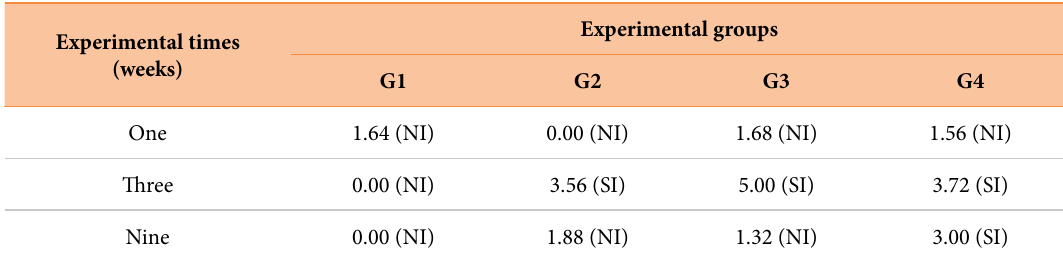
Table 1 - Irritation pattern of poultry collagen-based hydrogels in subcutaneous tissue in mice at one, three and nine weeks.